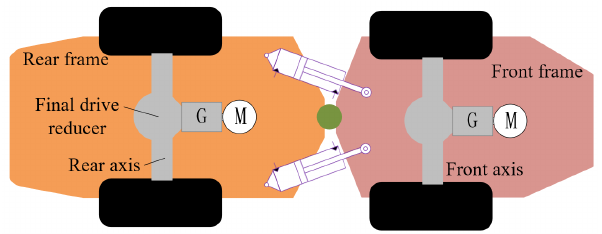
Figure 4. Main components of ASV power train.